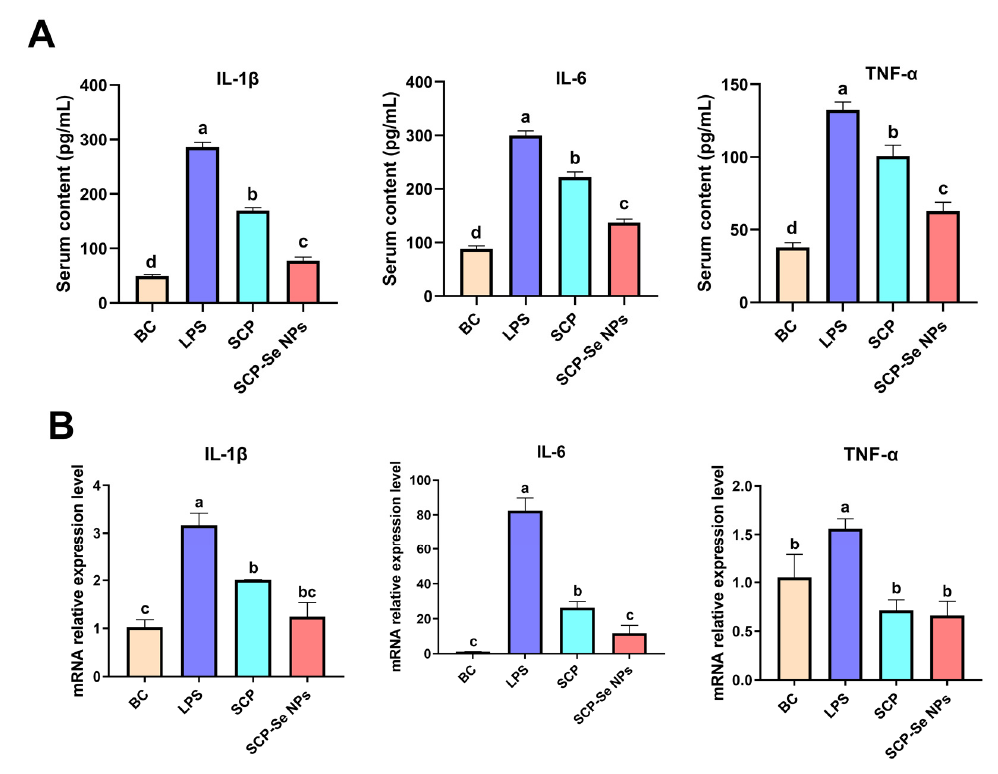
Figure 11. Effects of SCP-Se NPs on inflammatory cytokine (IL-1 β , IL-6, and TNF- α ) expression levels in LPS-treated mice. ( A ) Serum inflammatory cytokine (IL-1 β , IL-6, and TNF- α ) content. ( B ) Jejunum inflammation cytokine (IL-1 β , IL-6, and TNF- α ) relative expression level. Different lowercase letters (a–c) indicate significant differences ( p < 0.05).